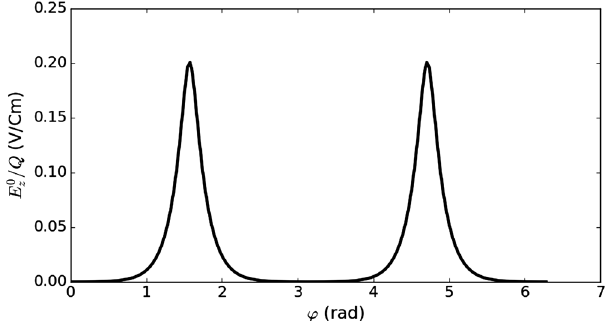
FIG. 5. Longitudinal electric field per unit of charge in the elliptic beam pipe of the SPS accelerator at the injection energy, calculated in μ 0 ¼ 0 . 1 at 100 MHz as a function of φ .